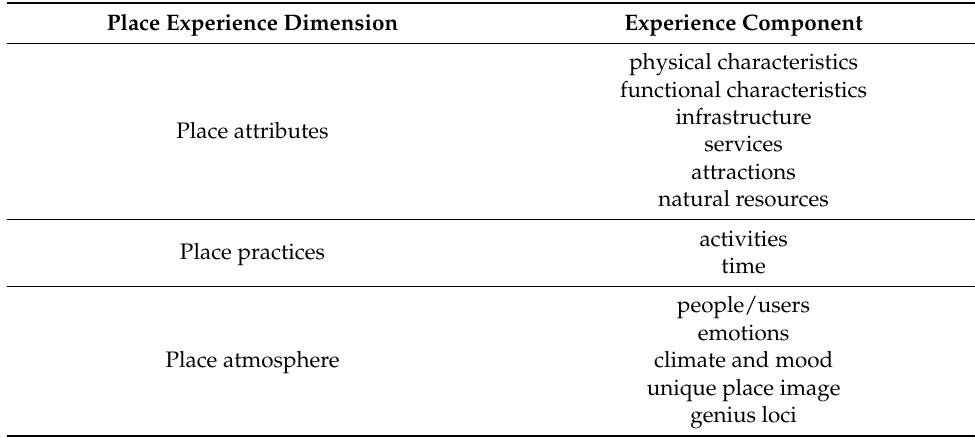
Table 2. Components of place experience